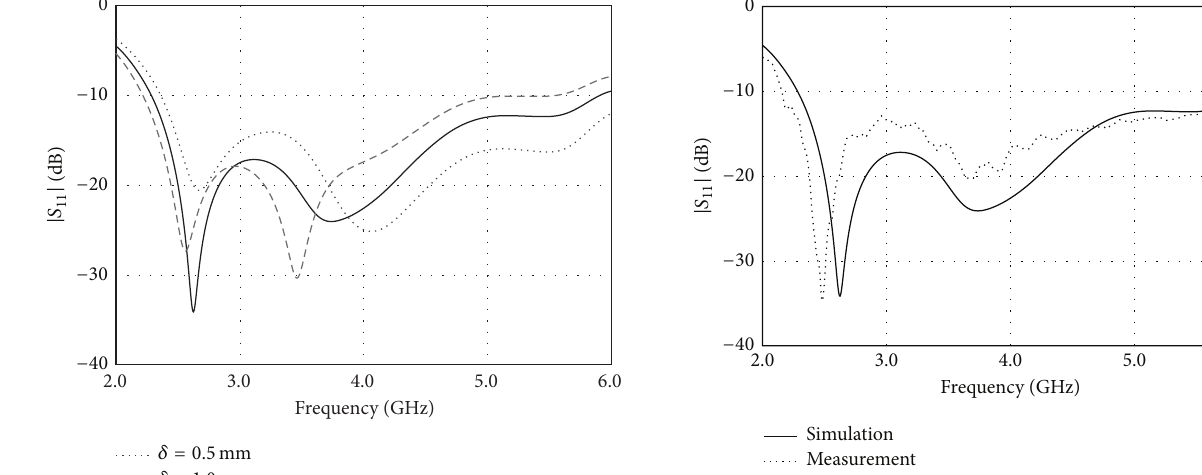
Figure 9: The comparison of the simulation and measured |𝑆 11 | relative to frequency.